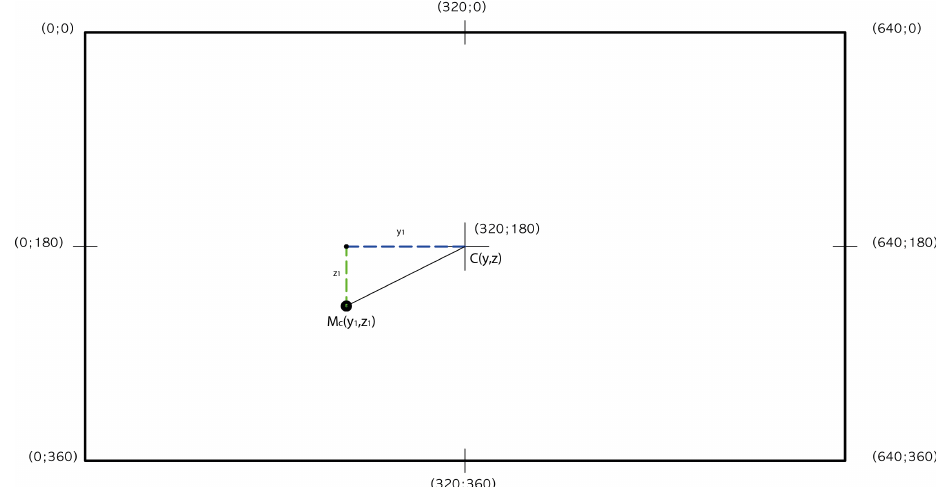
Figure 10. Obstacle mass center M c within visual field MAV camera. M c indicates the obstacle